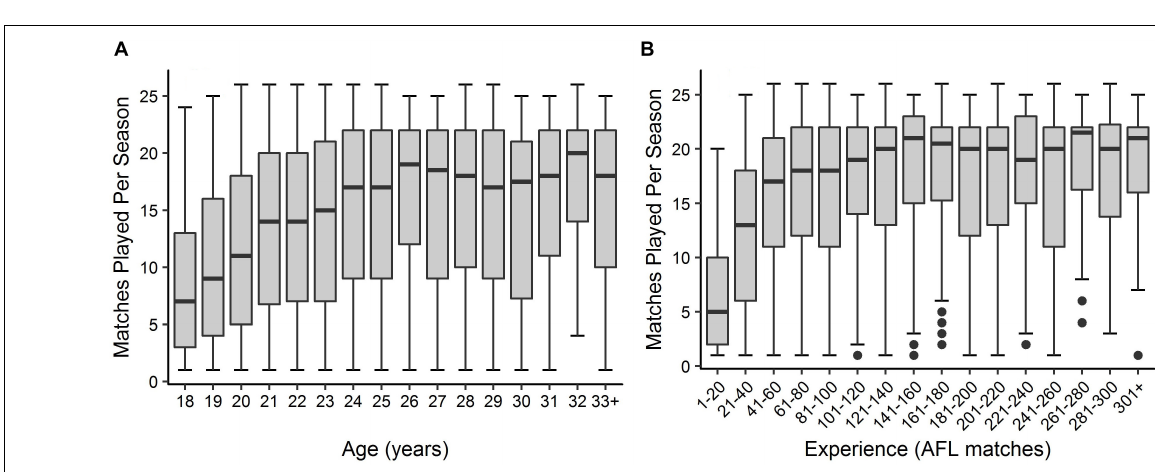
Frontiers in Psychology |